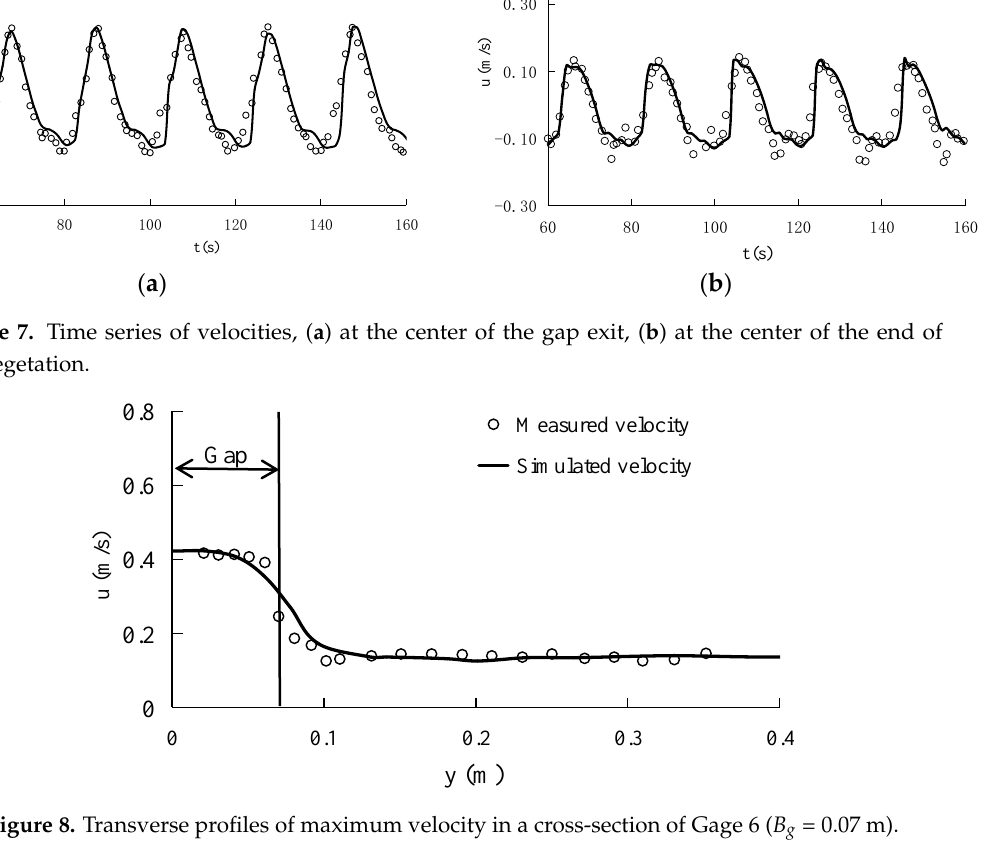
Figure 8. Transverse profiles of maximum velocity in a cross-section of Gage 6 ( B g = 0.07 m).